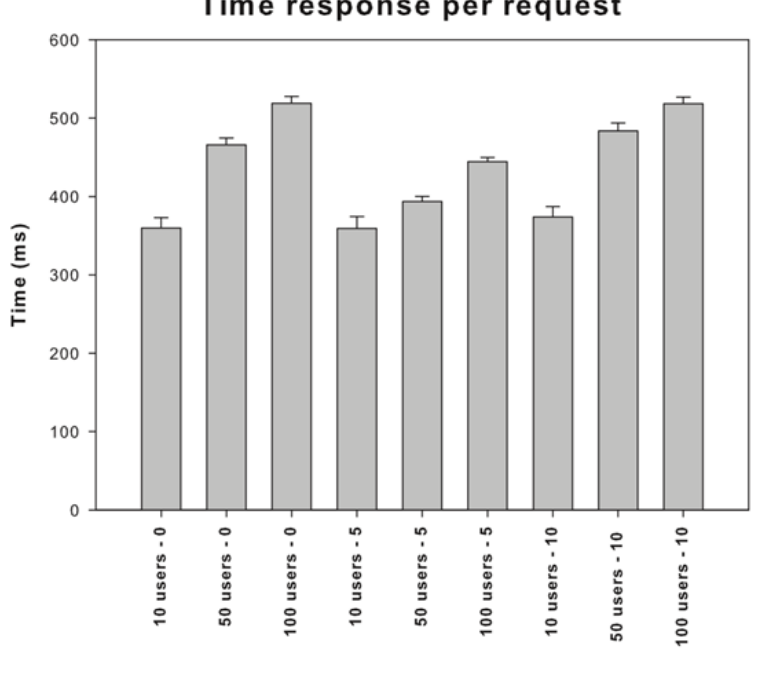
Figure 7. Mean and standard error of time queries for different combination of users.